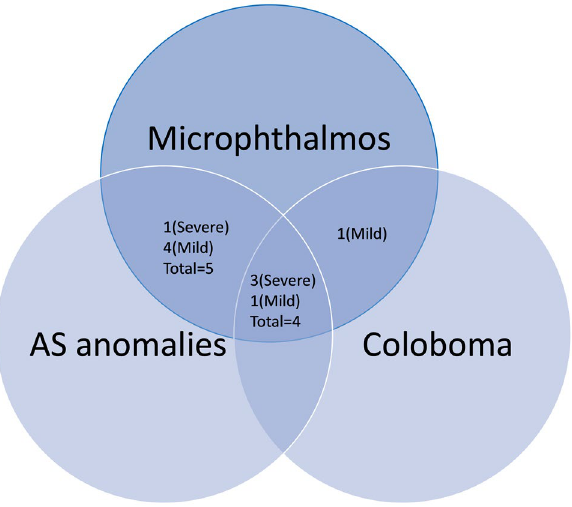
Figure 1. Venn diagrams representing the associations of 10 enucleated globes with microphthalmos, coloboma, and anterior segment (AS) abnormalities in relation to the severity of microphthalmos.